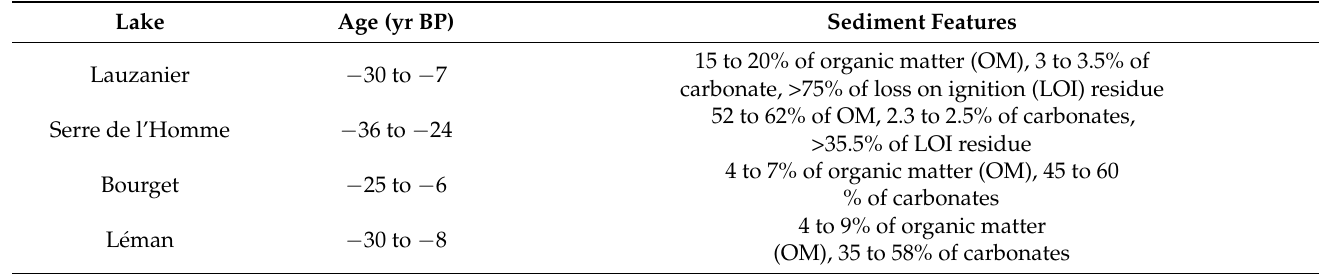
Table A4. Information about sediment samples used in this